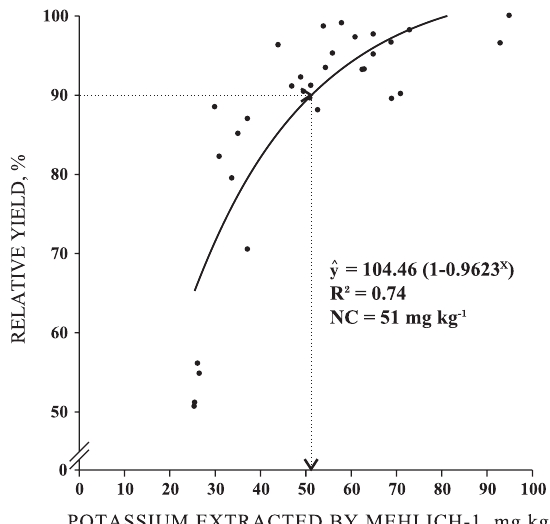
Figure 1. Relative yield and potassium content in the soil extracted by Mehlich-1 for grain crops grown in the period from 1991 to